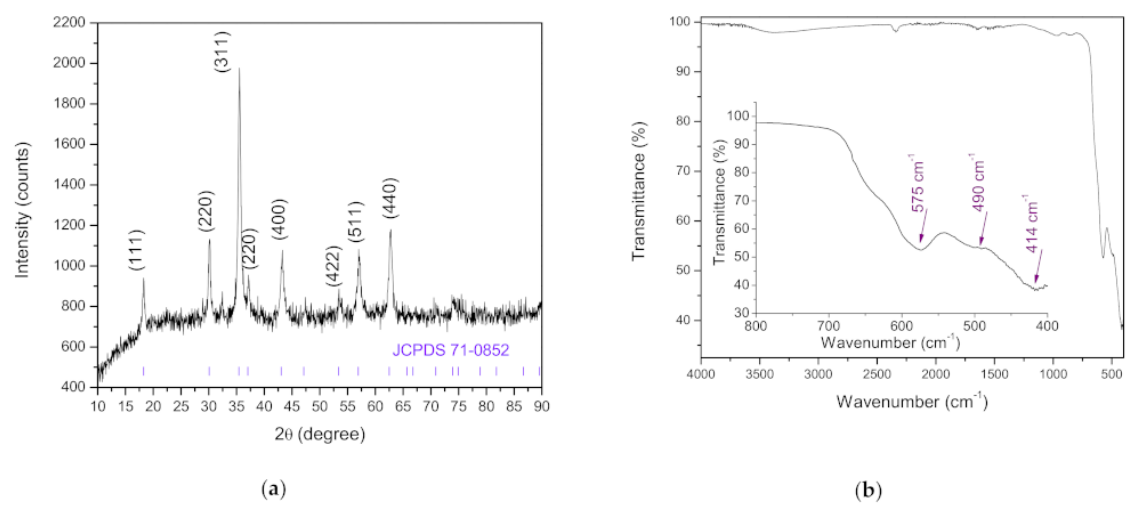
Figure 3. XRD diffractogram ( a ) and FT-IR spectrum ( b ) measured on NiMn 2 O 4 nanocrystalline